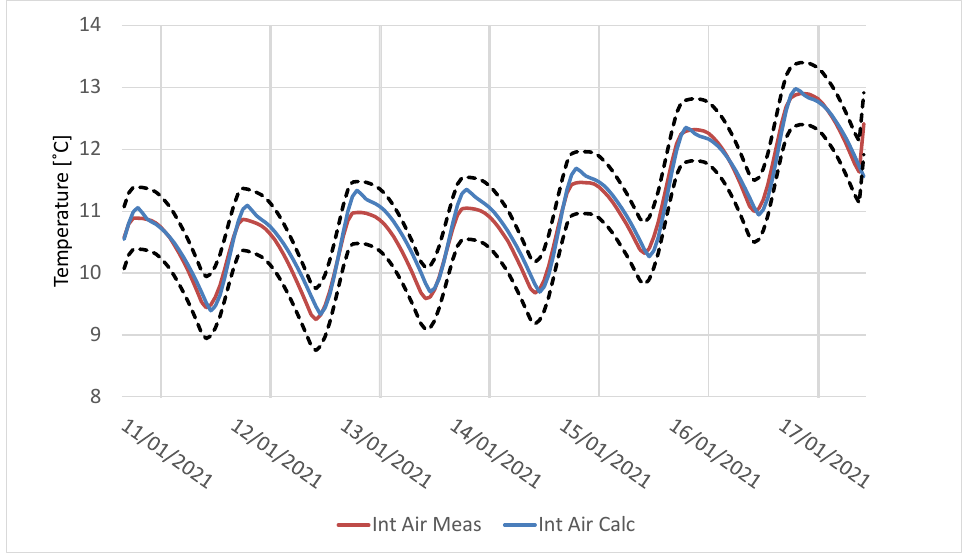
Figure 23. Cell 1. Winter. Grid open. Temperatures of the Cell 1 air indoor: measured ( ) and calculated ( ). Bands of ± 0.5 ◦ C, ( ), are shown.